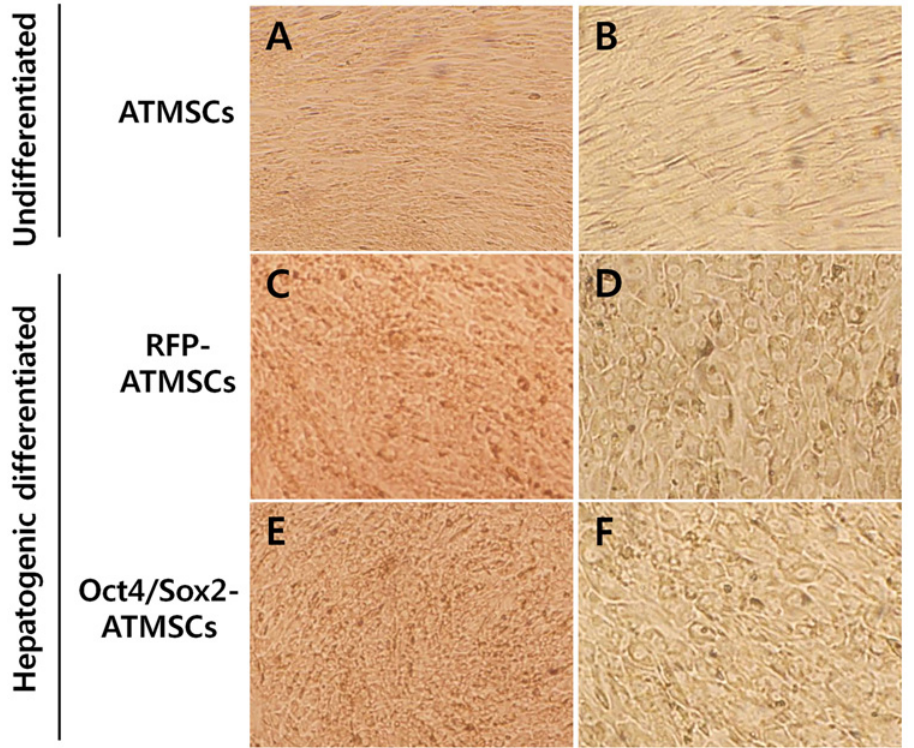
Fig 3. Morphology of RFP- and Oct4/Sox2-ATMSCs after 28 days hepatogenic differentiation. (A,B) Undifferentiated ATMSCs showed fibroblast-like morphology without morphological changes. (C,D) Hepatogenically differentiated RFP-ATMSCs and (E,F) hepatogenically differentiated Oct4/Sox2-ATMSCs exhibited significantly changed morphology and developed a round or polygonal epithelioid shape during step-2 of differentiation. Statistical analysis was performed by student t -test (significant, ** p <